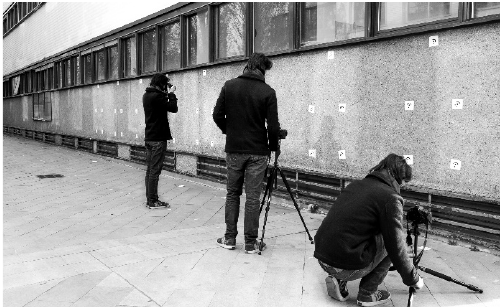
Figure 7. Capturing phase of the straight wall test.